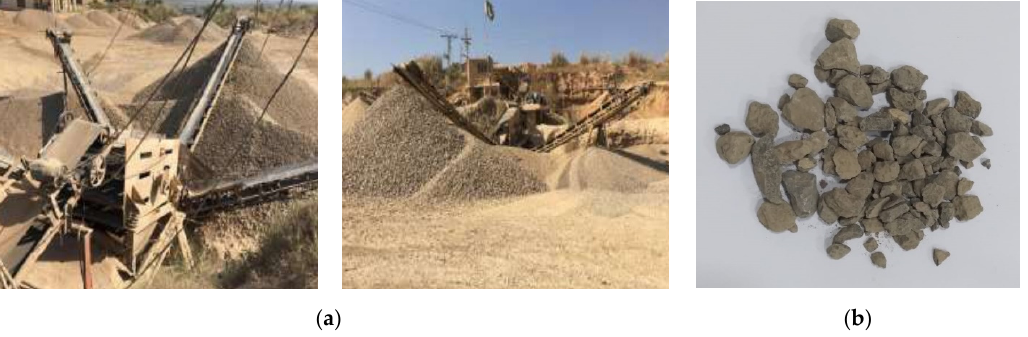
Figure 1. Aggregates used: ( a ) crusher site; ( b ) aggregates.